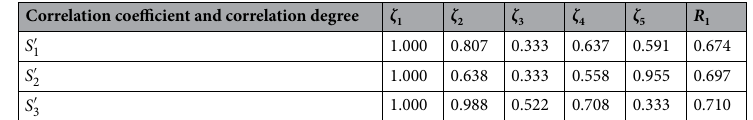
Table 6. Correlation with the first-level air standard.